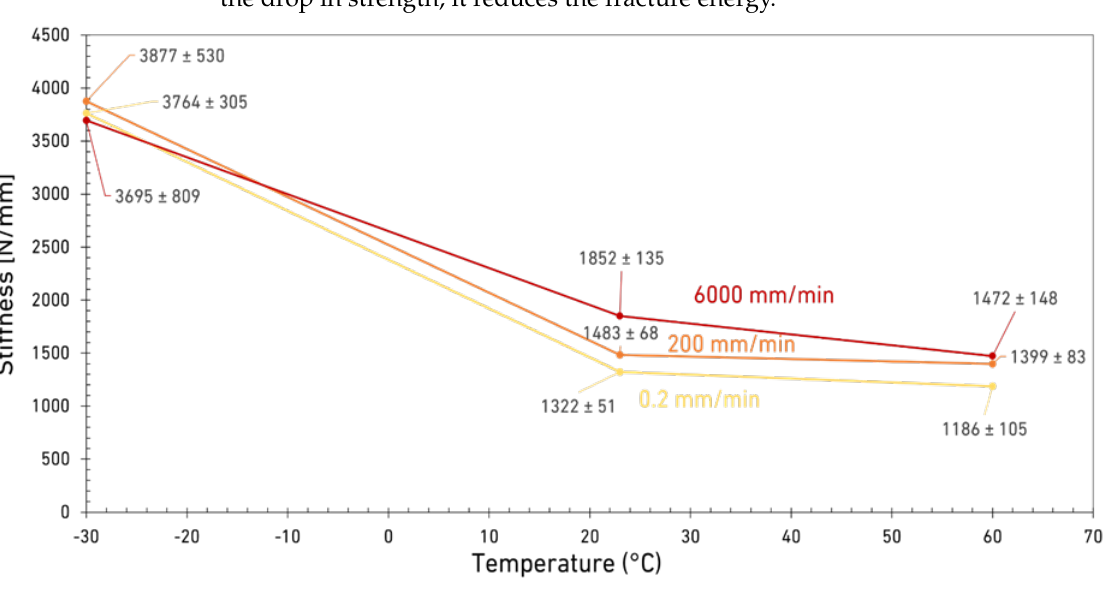
Figure 9. Stiffness as a function of temperature for three different loading rates.